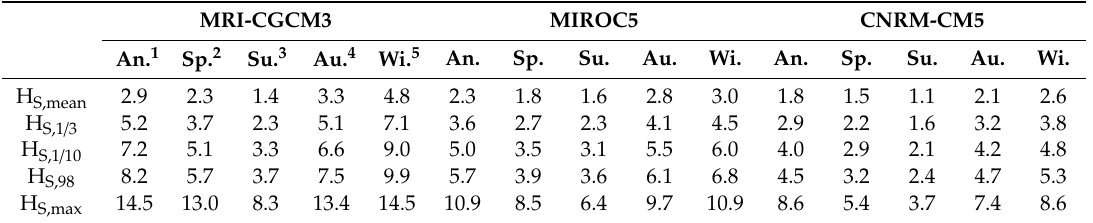
Table 4. Annual and seasonal statistics of the propagated values of H S at deep waters for the control scenarios (1986–2005) of all models analyzed (values in meters).